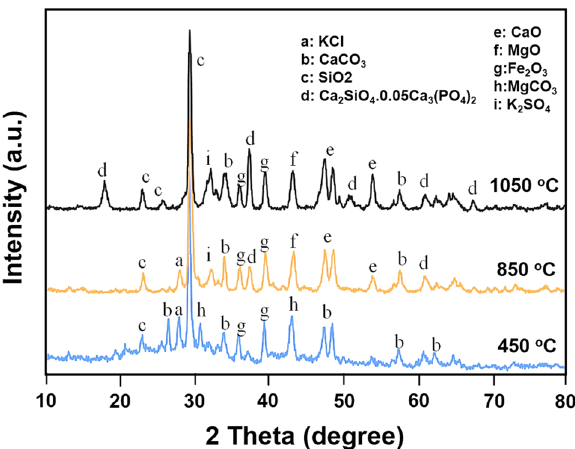
Figure 3. XRD pattern of WA at different combustion temperatures.